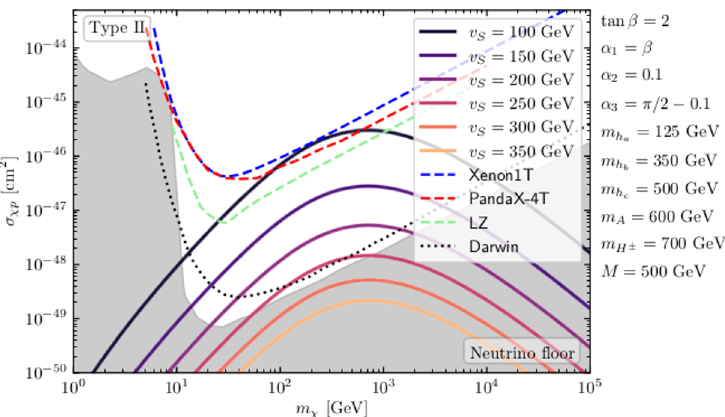
Figure 6 . DM-proton scattering cross section σ χp in dependence of the DM mass m χ for different values of the singlet vev v S in type II. The other parameters are fixed to the values shown on the right. Also shown are the current upper limits on the 95% confidence level from XENON1T [3] (blue dashed), PandasX-4T [2] (red dashed) and LZ [4] (green dashed), and the projected upper limit from Darwin [36] (dotted). The gray area indicates the neutrino floor